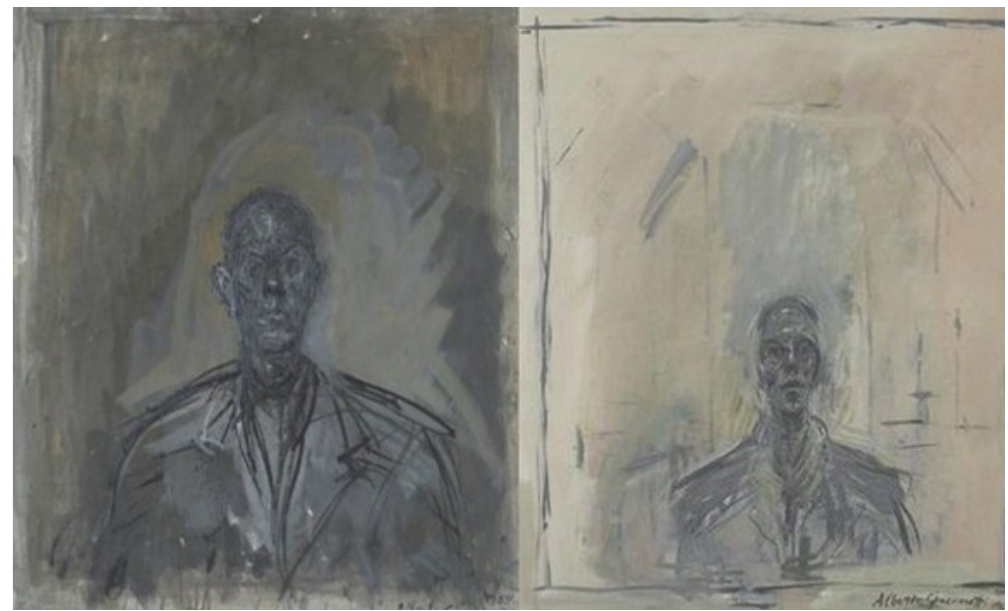
Fig. 1 Image showing Myatt’s fake Giacometti (left) next to a genuine Giacometti